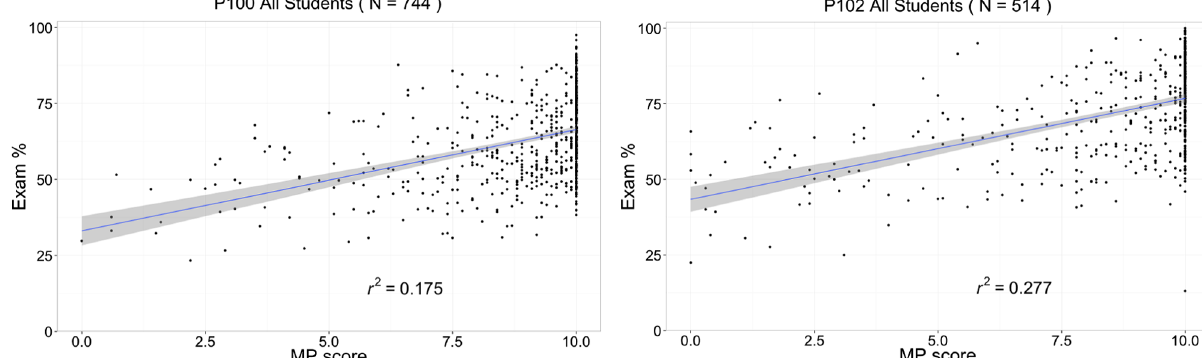
FIG. 1. Correlation between exam performance and Mastering Physics homework score (MP score) in two physics undergraduate courses at UBC. (a) Fig. 1(a) (left) The data for all students ( N ¼ 744 ) in the algebra-based introductory mechanics course P100 and (b) Fig. 1(b) (right) shows the data for all students ( N ¼ 514 ) in the calculus-based introductory electricity and magnetism course P102. The shaded areas indicate 95% confidence intervals. The median homework score is 9.9 in the case of P100 and 9.8 in the case of P102. The high scores are due to the use of extra problems (for bonus marks) in both courses to encourage practicing problem solving.